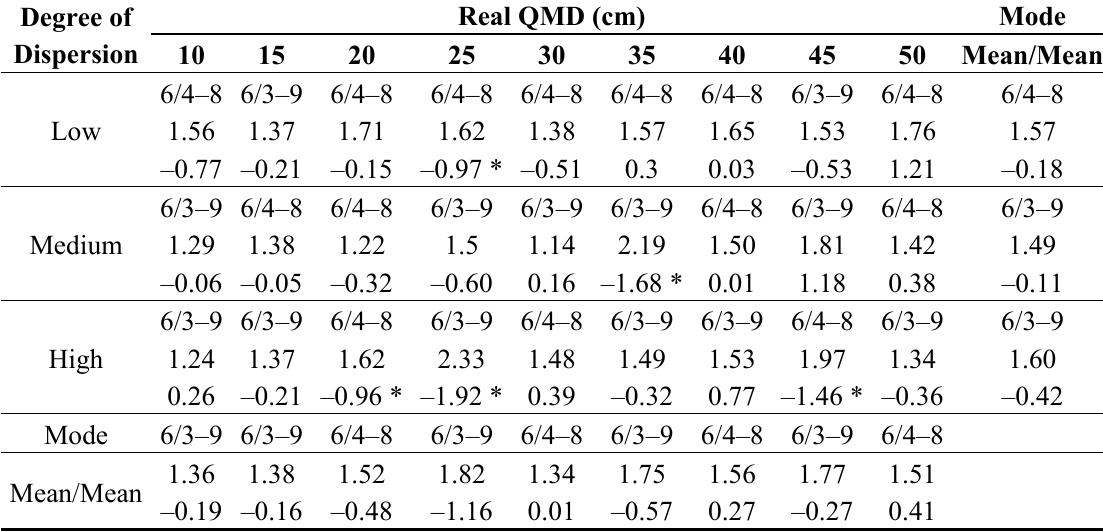
Table 7. The optimal centroid rank/combination of measured ranks, accuracy, and bias of QMD estimation for the best two-measurement variants of Weise’s rule (the values in columns for each combination of QMD and DoD are optimal rank centroid/combinations of measured ranks followed by RMSE and bias in